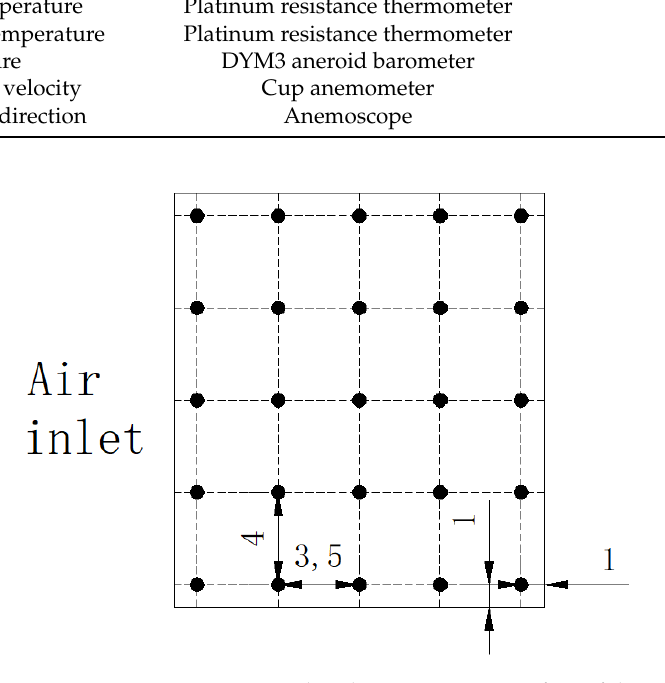
Figure 6. Measuring points distribution at water surface of the water basin. Table 2. Monitoring parameters and corresponding measuring instrument for the measurement.